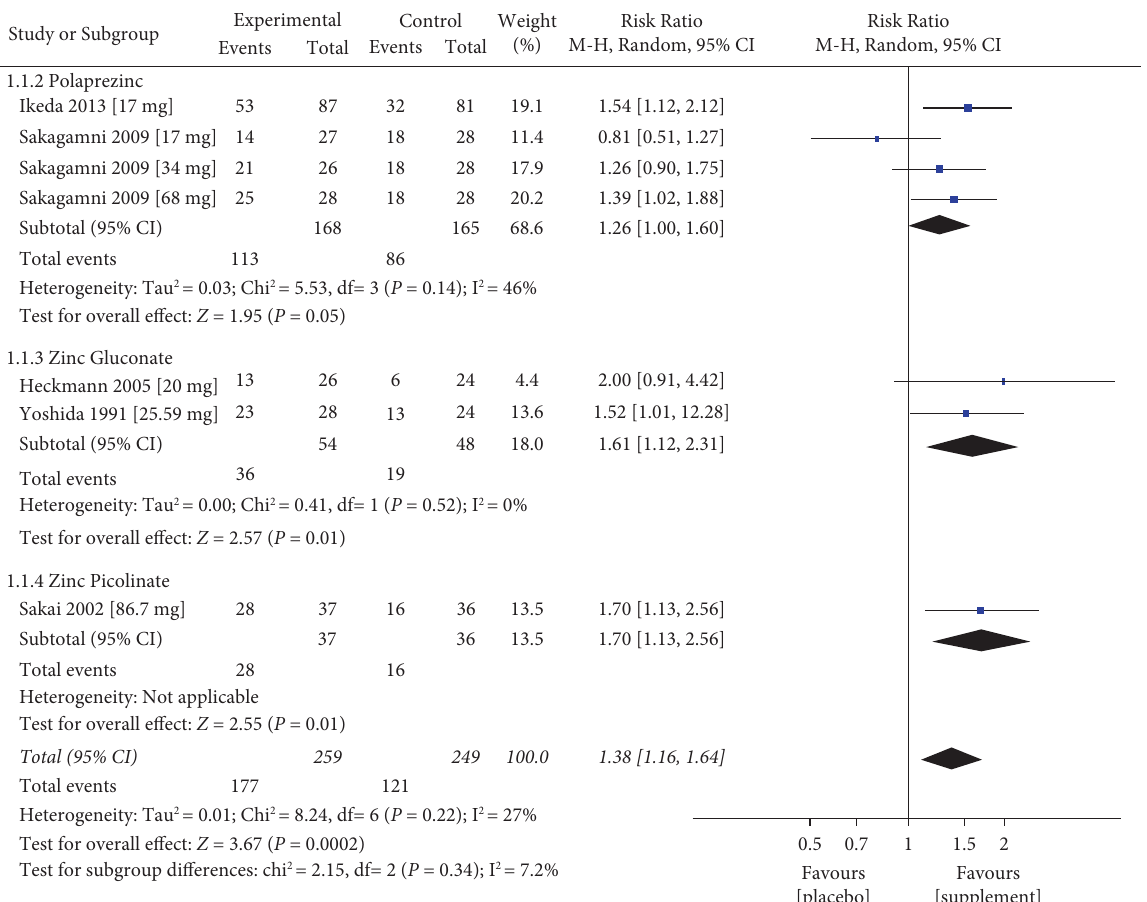
Figure 2: Meta-analysis of the efect of zinc replacement for the treatment of taste disorder. Forest plot including data analysis of fve studies with a total of 508 cases of idiopathic and zinc-defcient taste disorder enrolled to experimental ( n � 259) and control groups ( n � 249). Data expressed as event “total number of cases that improved after receiving the treatment or placebo,” and total “total number of participants in either control or experimental group” p value for heterogeneity was 0.22. Te pooled results of this meta-analysis indicated that taste disorder improvement occurred signifcantly more frequently in the supplemented group compared to the control group. Overall RR is positive (RR � 1.38, 95% CI � 1.16–1.64), and statistical signifcance was found to be p � 0 .